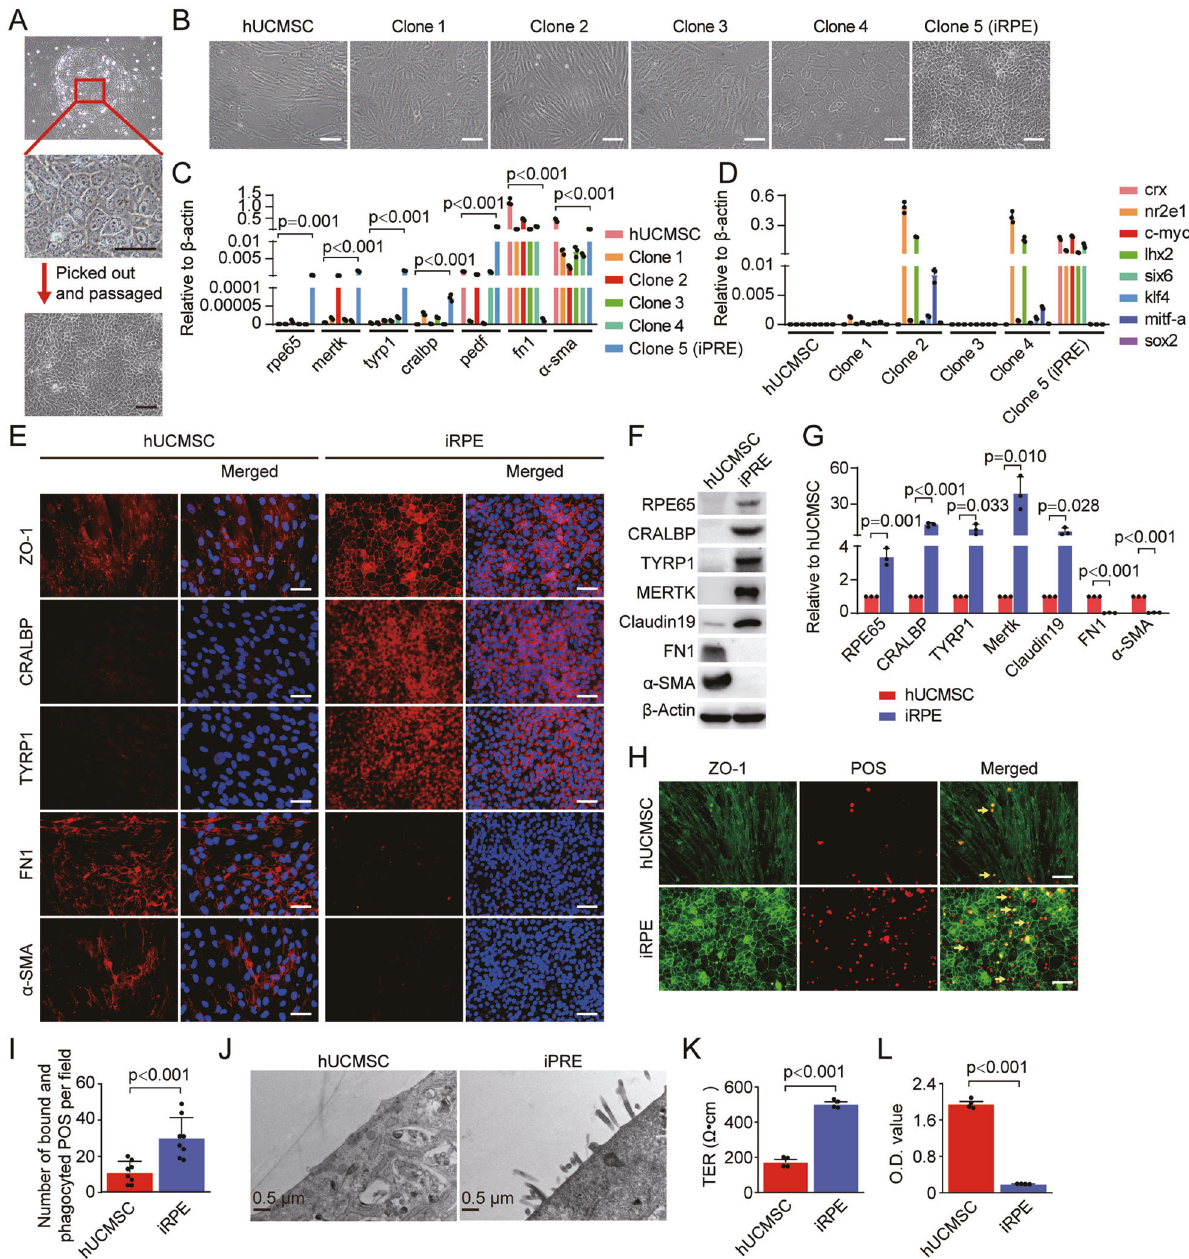
Fig. 1 Five TFs transdifferentiate hUCMSCs into iRPE Cells. Retroviruses carrying 8 TF genes (crx, nr2e1, c-myc, lhx2, six6, klf4, mitf-a, and sox2 ) were used to transfect hUCMSCs. A The representative colony of hUCMSCs transfected with 8 TFs was picked out and passaged. B Representative images of induced cell colonies. C The expression levels of RPE-speci fi c markers, EMT-related markers, and D exogenous TFs were determined by qRT-PCR ( n = 3, P value measured by one-way ANOVA and post hoc Bonferroni ’ s test). RPE-speci fi c and EMT-associated markers were detected by E immunostaining, F Western blotting, and G quantitative analysis ( n = 3, P value measured by Student ’ s unpaired t test). H Total bound and phagocyted POSs (pointed by arrows) in hUCMSCs and iRPE cells. I Quanti fi cation of phagocytosis, as determined by the number of bound and phagocyted POS per fi eld ( n = 8, P value measured by Student ’ s unpaired t test). J Electron micrographs of hUCMSCs and iRPE cells. K TER analysis ( n = 4, P value measured by Student ’ s unpaired t test). L HRP permeability assay ( n = 4, P value measured by Student ’ s unpaired t test). Scale bar = 50 μ m. Results are expressed as mean ±